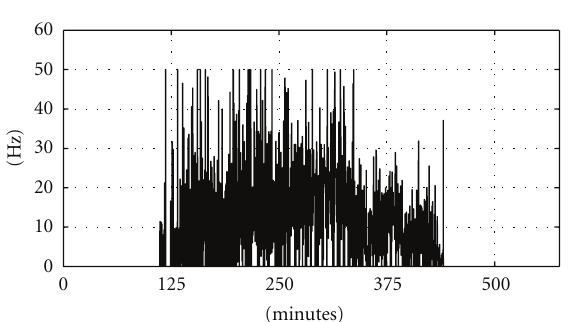
Figure 11: Action control of the fuzzy controller.